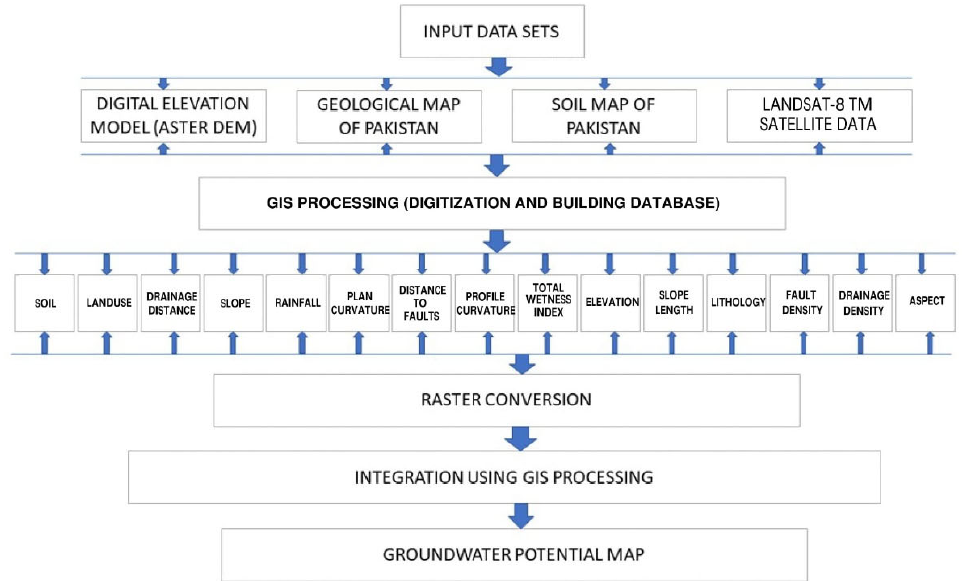
Figure 2. Flowchart for potential groundwater assessment using integrated remote sensing and GIS techniques.